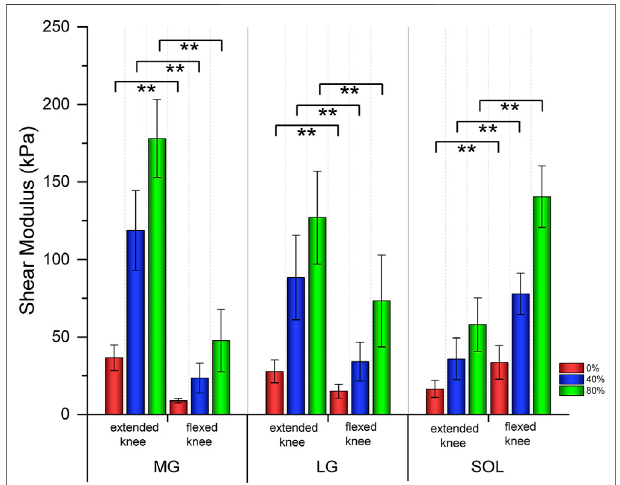
FIGURE 2 | Bar graphs of the shear modulus of three triceps surae muscles between extended and fl exed knee. ** means signi fi cant intergroup difference ( p < 0.001). Red, blue, and green represent no contraction (0%), 40%, and 80% maximum voluntary contraction (MVC) during isometric plantar fl exion, respectively. MG: medial gastrocnemius; LG: lateral gastrocnemius; and SOL: soleus.